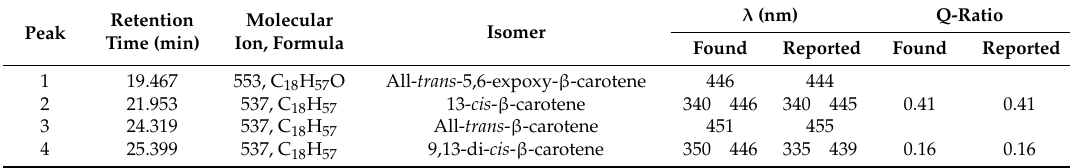
Table 4. Product identification of β -carotene treated with BMFDS under UVA irradiation.